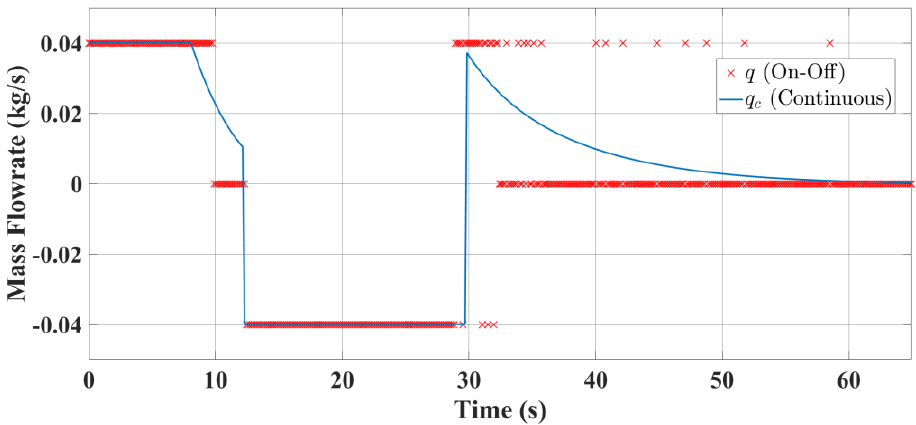
Figure 5. Mass flowrates of on-off and continuous type VBS control.